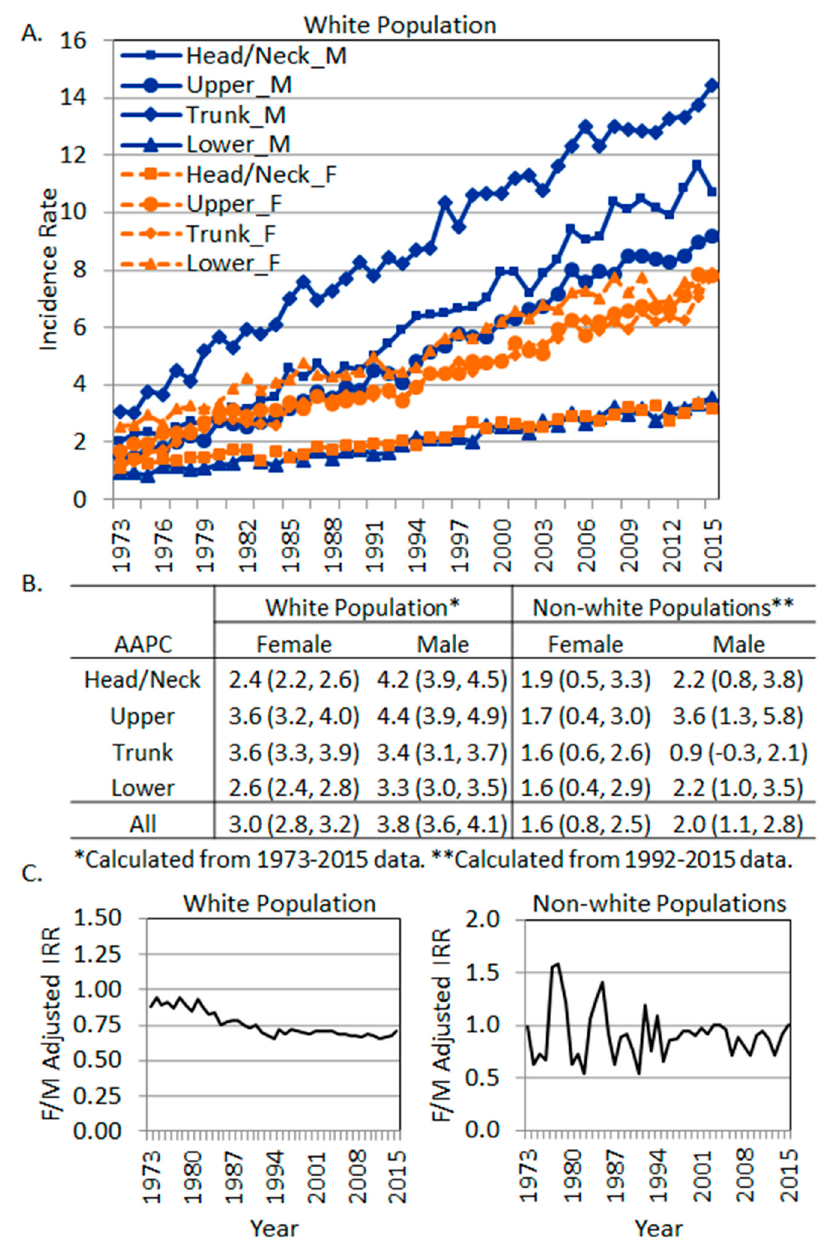
Figure 3. The trend of site-specific melanoma incidence rates by sex. ( A ) Incidence rates in the white population. ( B ) Average annual percentage change of site-specific incidence rates in each sex. ( C ) Overall female to male incidence rate ratios (SEER 9 data, 1973–2015). Left, white population. Right, non-white populations.